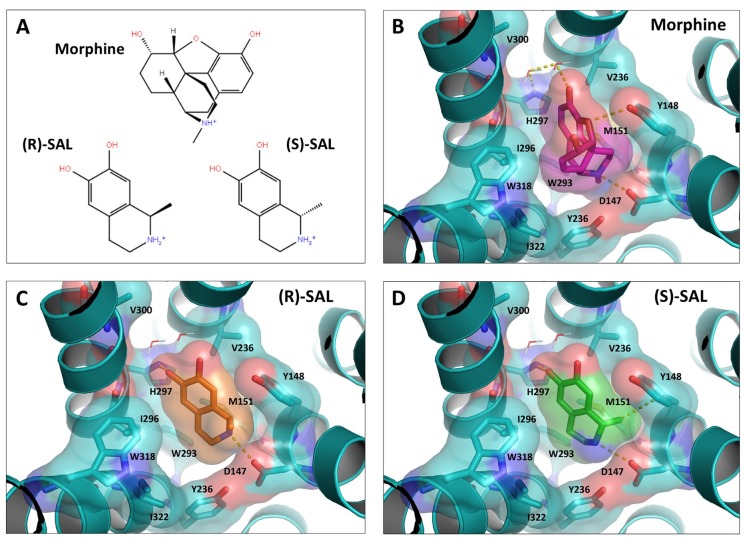
(R)-SAL and (S)-SAL stereoisomers showed a morphine-like interaction with the binding site of the μ-opioid receptor. Molecular docking analyses of morphine, (R)-SAL and (S)-SAL on the coordinates of the crystallized mouse μ-opioid receptor were performed. (A) Chemical structure of the molecules studied: morphine, (R)-SAL and (S)-SAL. Hydroxyl groups are represented in red and amino groups are represented in blue. (B–D) Best docking fits of the three studied molecules on the binding site of the μ-opioid receptor. The molecular surface of each molecule and the receptor is represented. A dotted line highlights the main interactions of the ligands with the binding site of the μ-opioid receptor.